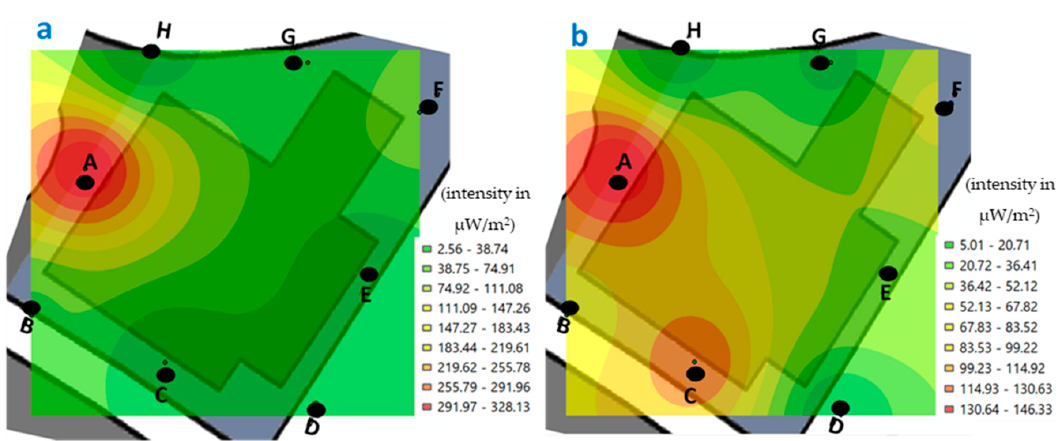
Figure 10. Georeferenced map with the levels of exposure registered in the H building (professors’